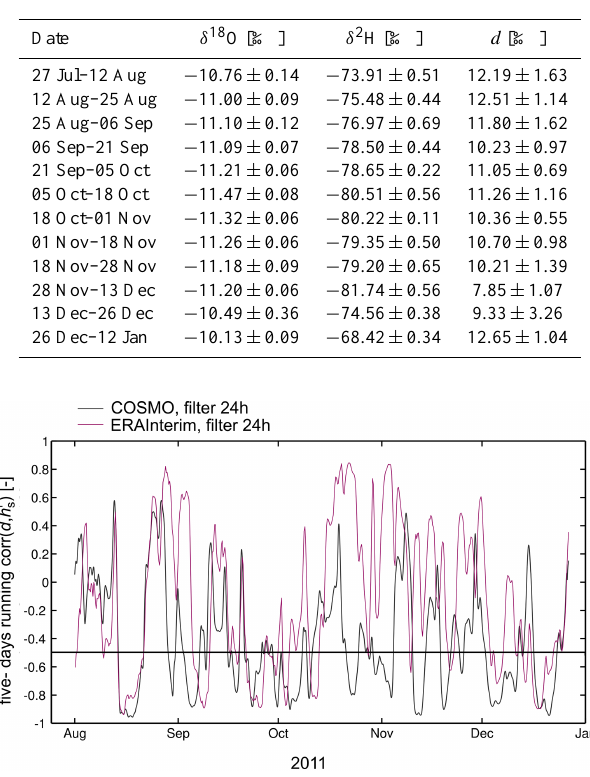
Table A1. Isotopic composition of ∼ 10 days accumulated soil moisture samples from the lysimeter collected at the measurement station Rietholzbach between 27 July 2011 and 12 January 2012.